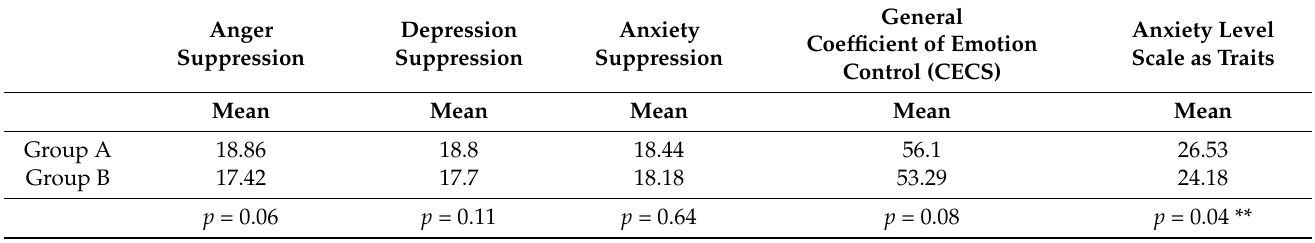
Figure 1. Percentage spread of emotion suppression levels according to the CECS scale. Our analysis of anxiety level as a personality trait, i.e., compared to the constant value present in human life according to the SL-C scale, showed that the coefficient of anxiety intensity in the research group ranged from 2 to 44 points. The mean value of this scale was 25.35 ± 7.97, with 26.53 in Group A and 24.18 in Group B; p = 0.04. The result of SARS-Cov-2 testing was not an important factor influencing the levels of emotional suppression. However, nurses from Group A showed a higher anxiety intensity compared to those in Group B ( p = 0.04); Table 3. Table 3. Correlation between COVID-19 infection and emotions experienced by